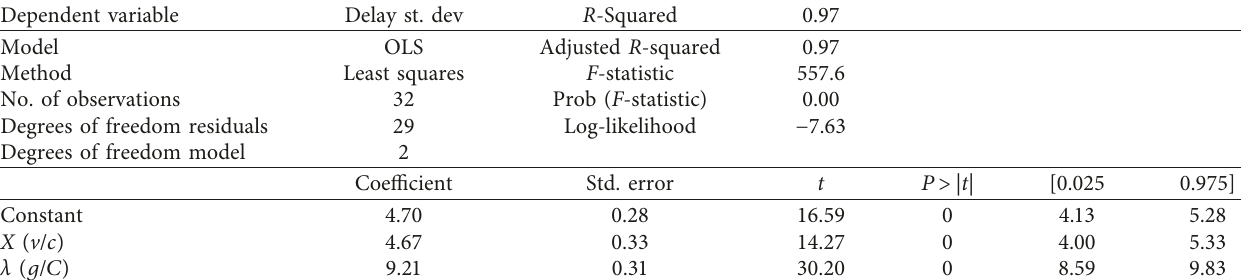
Table 10: ANOVA results for linear regression.